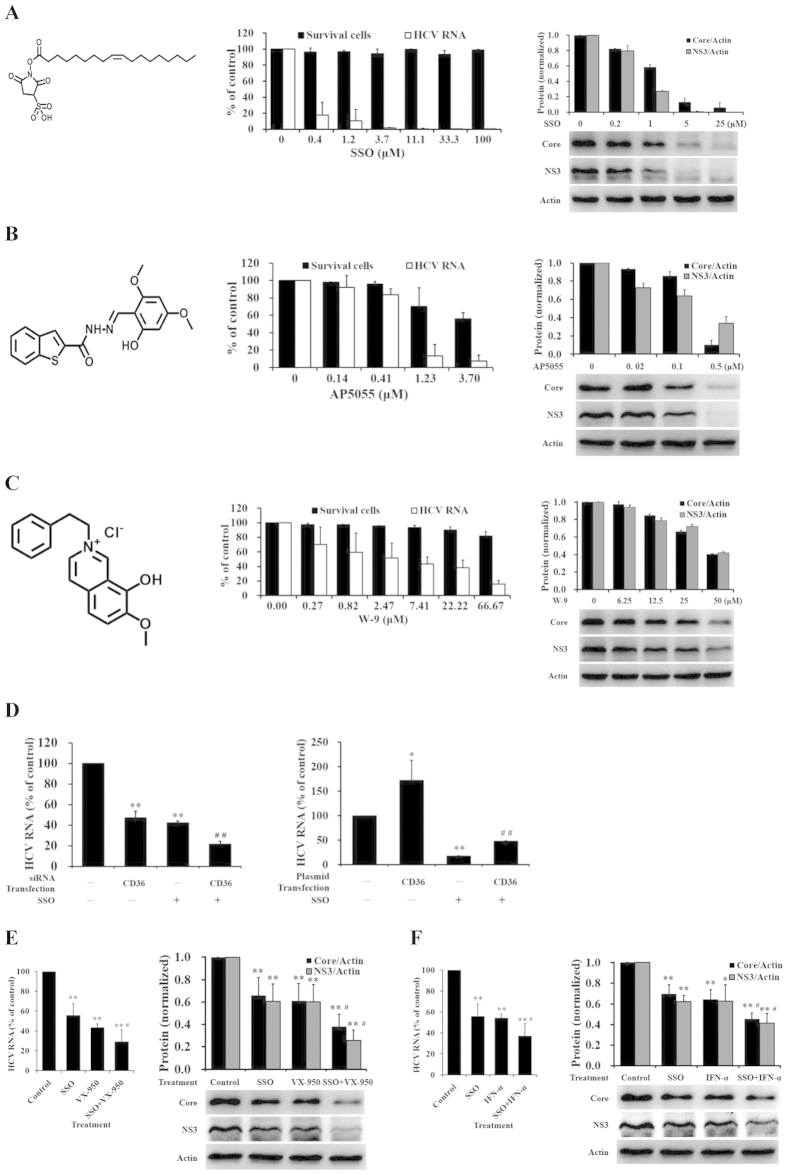
CD36 inhibitors blocked HCV replication in vitro.(A–C) CD36 inhibitors prevented HCV from replicating (n = 3). Huh7.5 cells were infected with HCV (45 IU/cell) and simultaneously treated with compound SSO (A), AP5055 (B), W-9 (C) or solvent control. After 72 hrs incubation, intracellular RNA and proteins were detected, and cytotoxicity was measured with MTT assay (Middle). (D) The anti-HCV activity of SSO was affected by the level of CD36 (n = 3). Huh7.5 cells were transfected with 150 pmol siRNA for CD36 (Left) or with 0.2 μg CD36 plasmid (Right). After 48 hrs, the cells were washed and infected with HCV (150 IU/cell) and simultaneously treated with 5 μM SSO for 2 hrs, followed by washing and continuously incubating with fresh media. Intracellular HCV RNA was detected in 96 hrs. *P < 0.05 and **P < 0.01, vs siRNA (or plasmid) control plus solvent control group; ##P < 0.01, vs siRNA (or plasmid) control plus SSO group. (E) SSO in combination with VX-950 inhibited HCV replication in an additive manner (n = 3 for RNA, n = 4 for protein). (F) Increased anti-HCV effect of SSO in combination with IFN-α (n = 3 for RNA, n = 4 for protein). Huh7.5 cells were infected with HCV (45 IU/cell) and incubated with SSO (1.0 μM) or VX-950 (0.1 μM), or the combination of SSO and VX-950 (E), or incubated with IFN-α (1.0 U/mL), or the combination of SSO and IFN-α (F). Intracellular RNA and proteins were detected in 72 hrs. *P < 0.05 and **P < 0.01, vs solvent control; #P < 0.05, vs VX-950 or IFN-α alone. The protein bands showed the results of a representative experiment. Presented are mean ± standard deviation. Student’s t-test was used in (D–F).